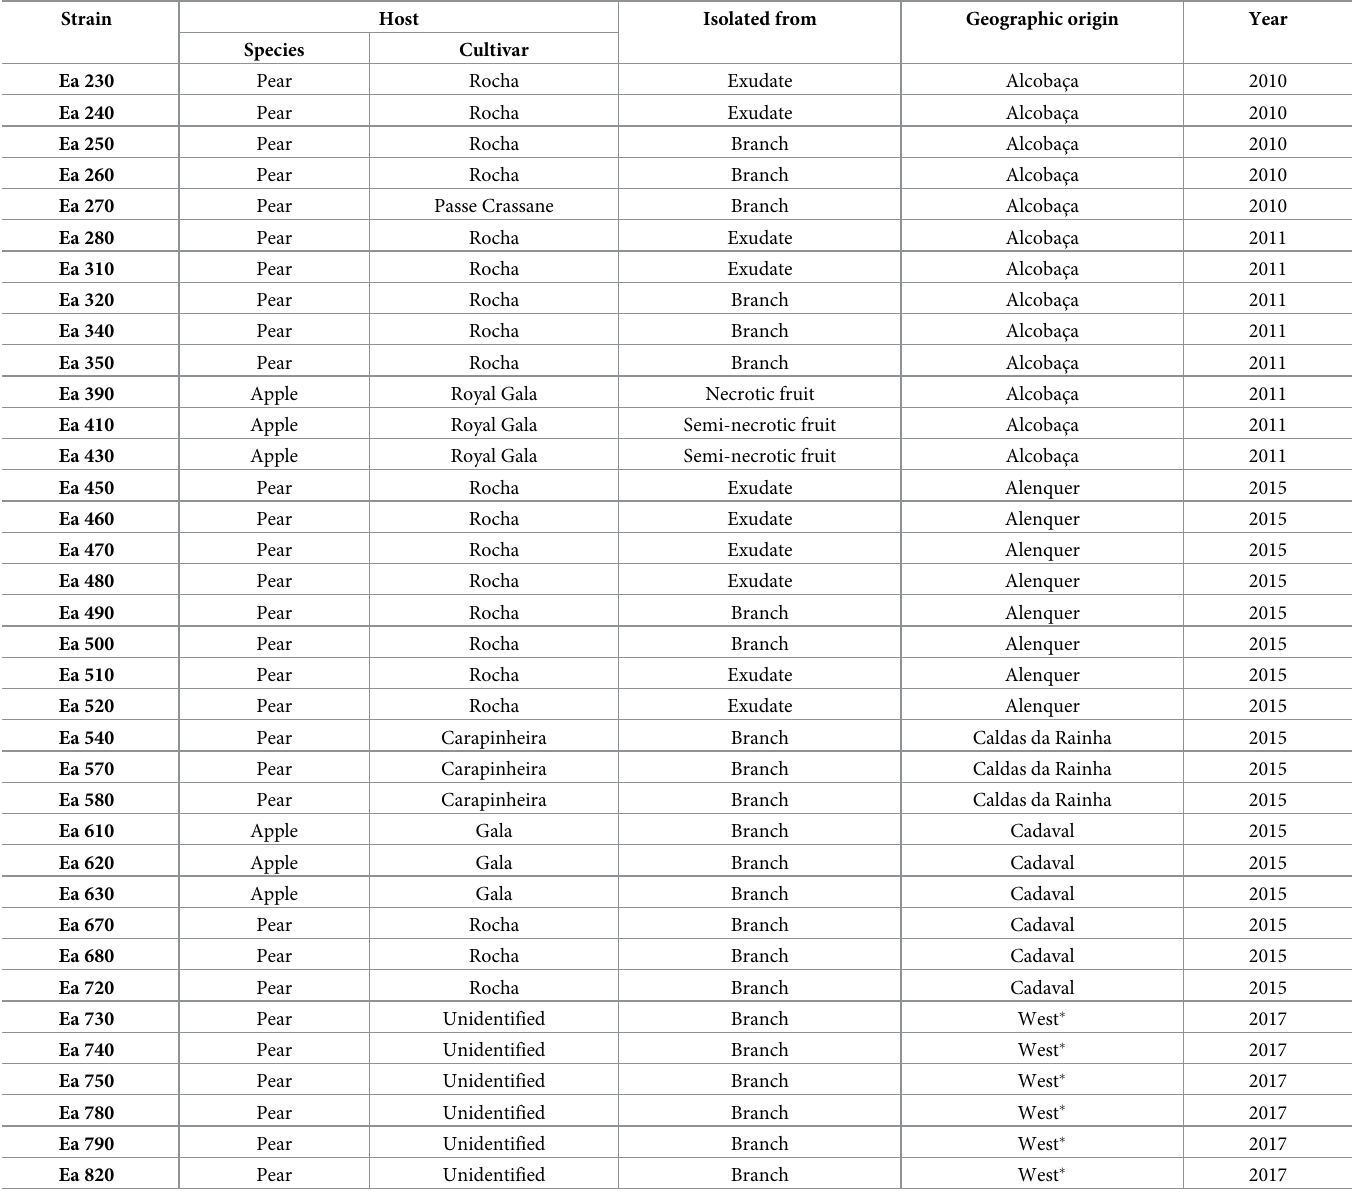
Table 1. Portuguese Erwinia amylovora isolates used in this work.